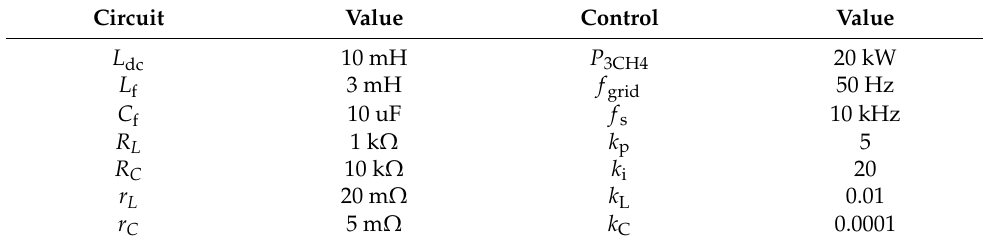
Table 1. 3CH4 system